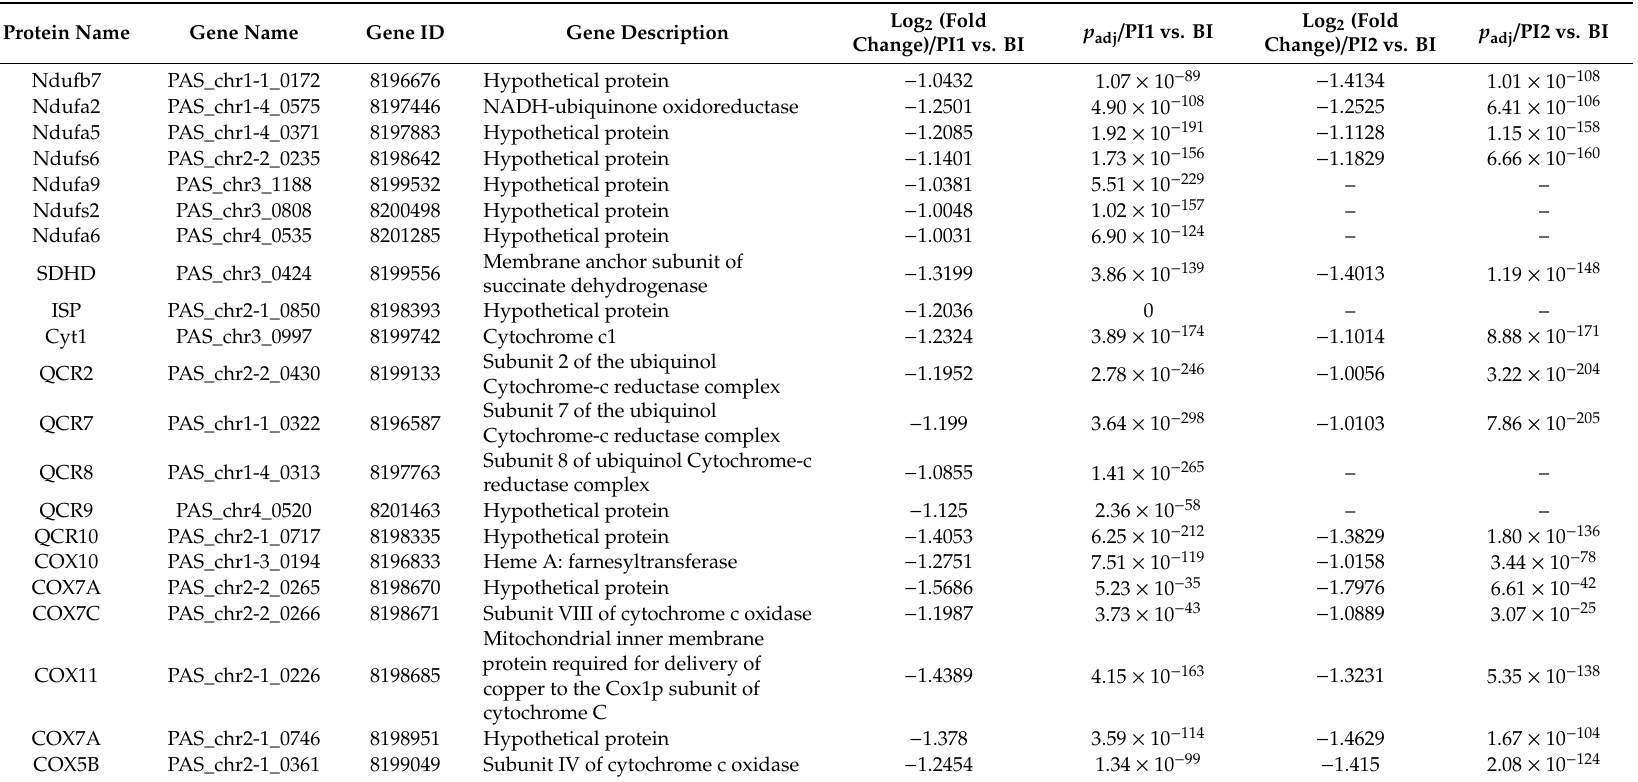
Table 2. List of DEGs involved in mitochondrial oxidative phosphorylation process in PI1 and PI2 in comparison to